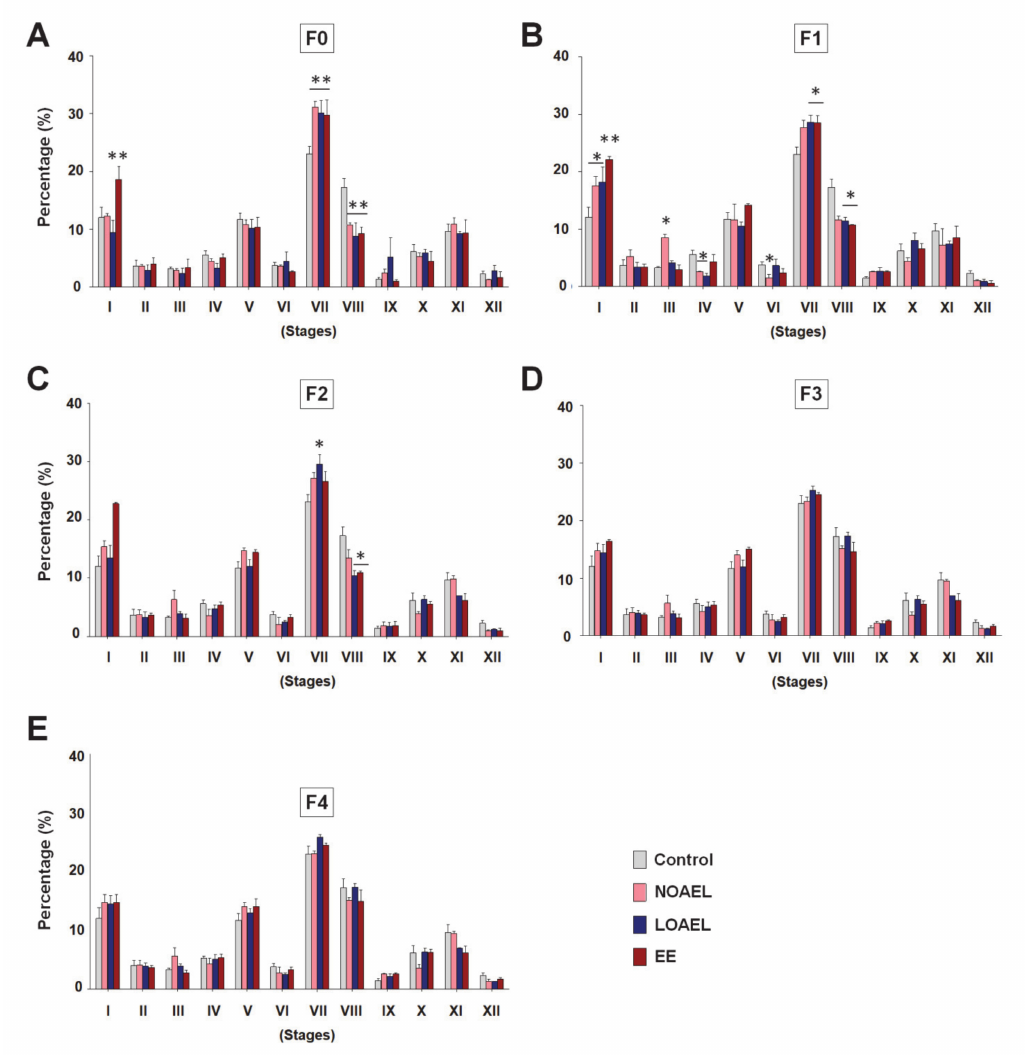
Figure 3. Staging of seminiferous epithelium (SE). Testicular sections were stained with periodic acid–Schi ff (PAS)-hematoxylin and eosin, and SE staging was performed to assess the di ff erences due to bisphenol-A exposure. The bar graphs show the staging patterns of ( A ) exposed group (F0) ( n = 9 mice / group), ( B ) F1 generation ( n = 9 mice / group), ( C ) F2 generation ( n = 9 mice / group), ( D ) F3 generation ( n = 9 mice / group), and ( E ) F4 generation ( n = 9 mice / group). For each stage, the di ff erence between exposed and control groups was assessed by one-way analysis of variance (ANOVA) (* p < 0.05 and ** p < 0.01